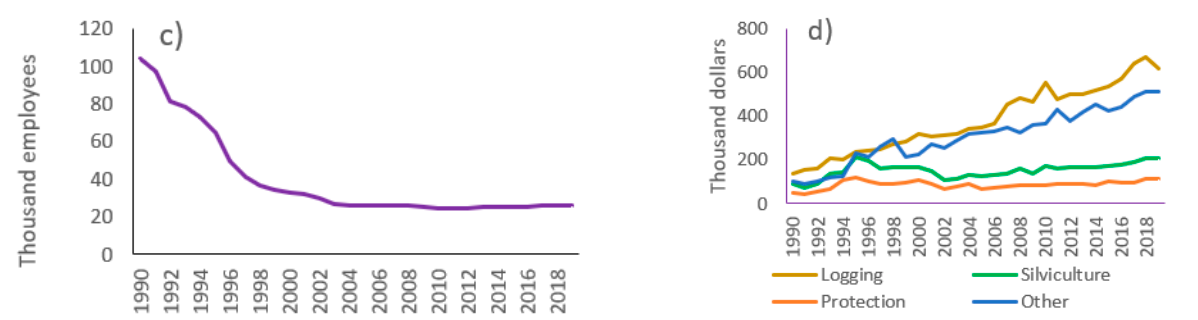
Figure 1. Output ( a ) and different inputs of timber production: ( b ) standing volume (left axis) and forested area (right axis); ( c ) labor costs; ( d ) costs of logging, silviculture, forest protection, and other costs.